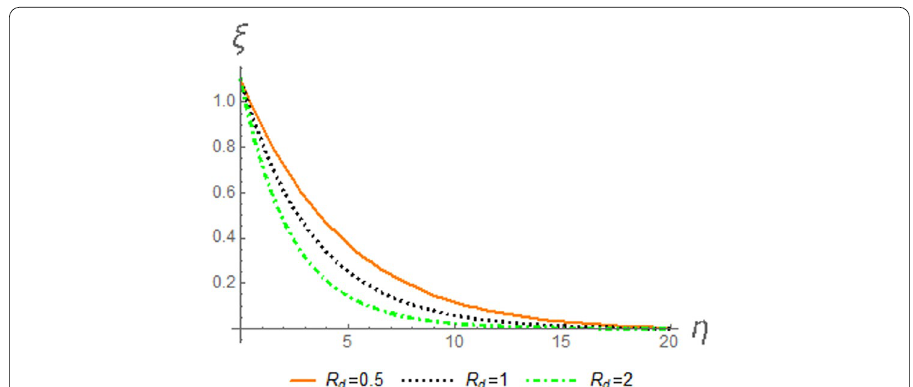
Fig. 11 Effect of R d on the temperature profile